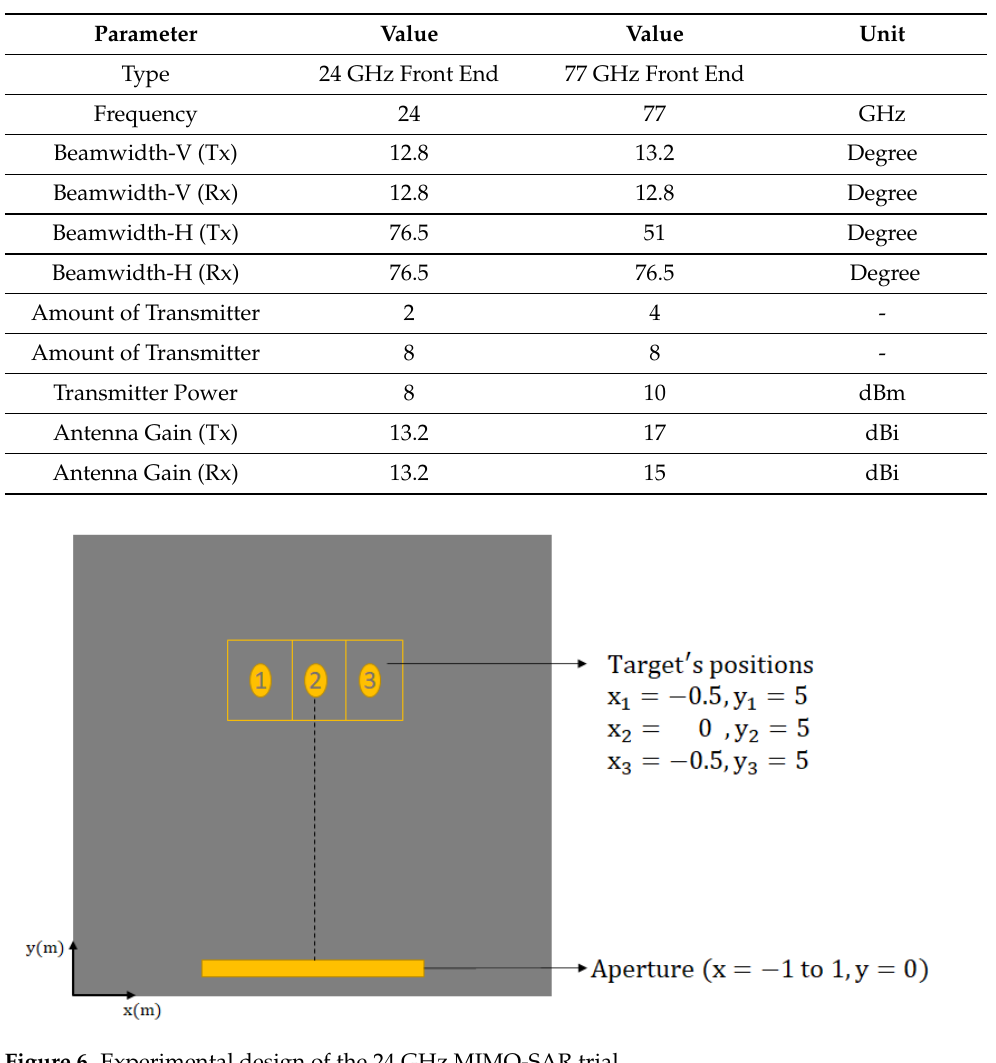
Figure 6. Experimental design of the 24 GHz MIMO-SAR